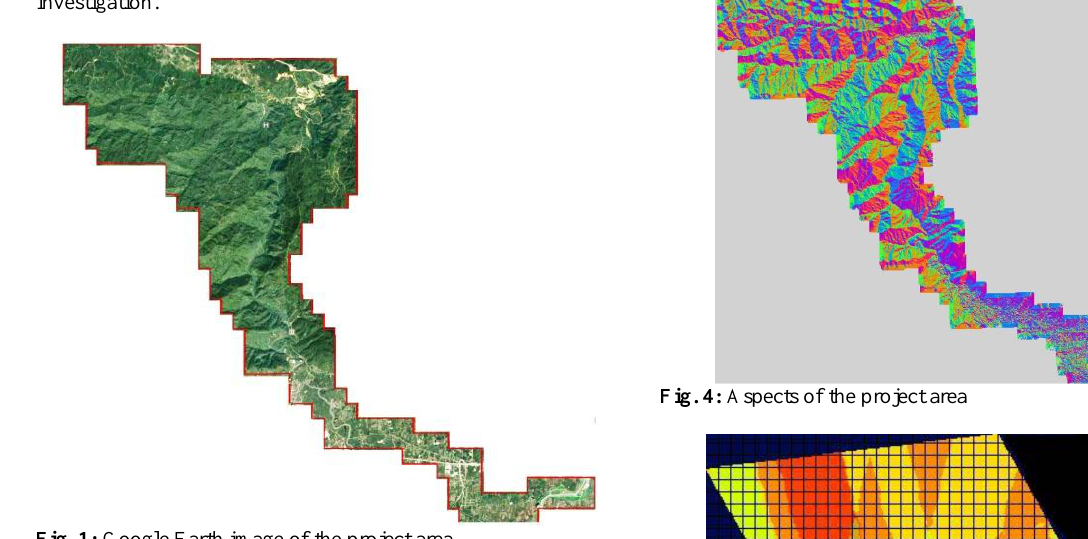
Fig. 1: Google Earth image of the project area